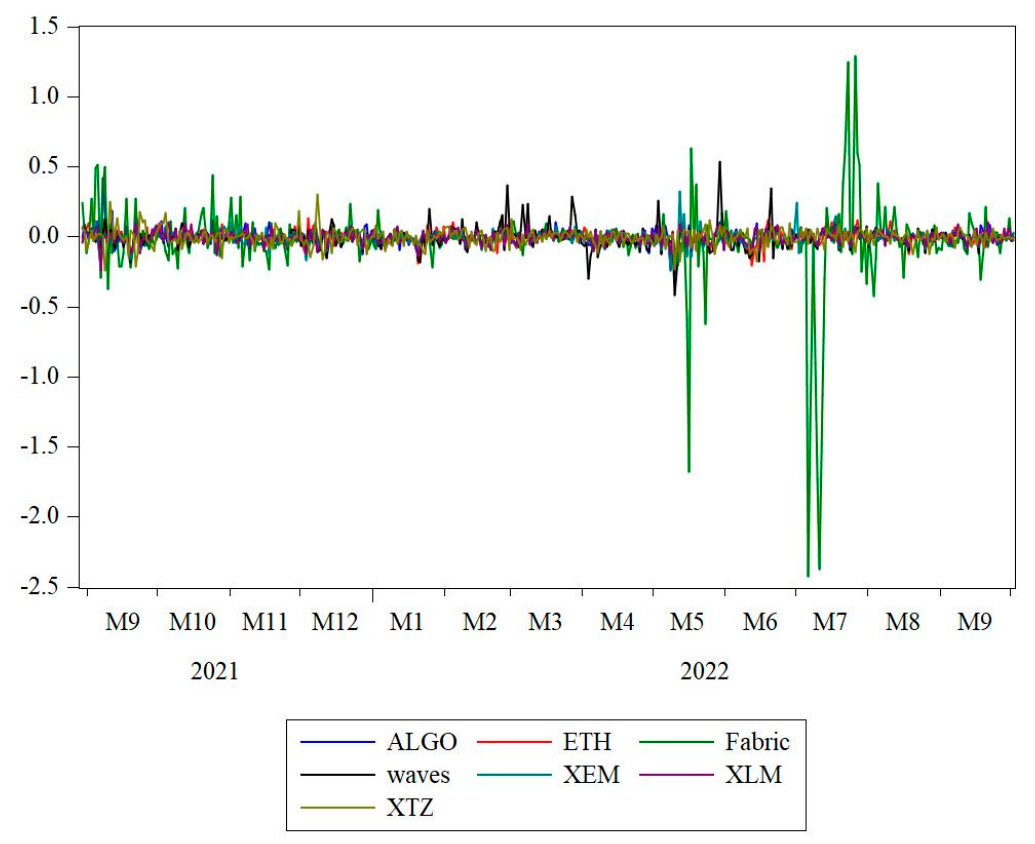
Figure 1. Log Returns of the smart contract platforms (SMs). Note: Log returns (natural) is depicted in the figure above for all the variables used in this study.